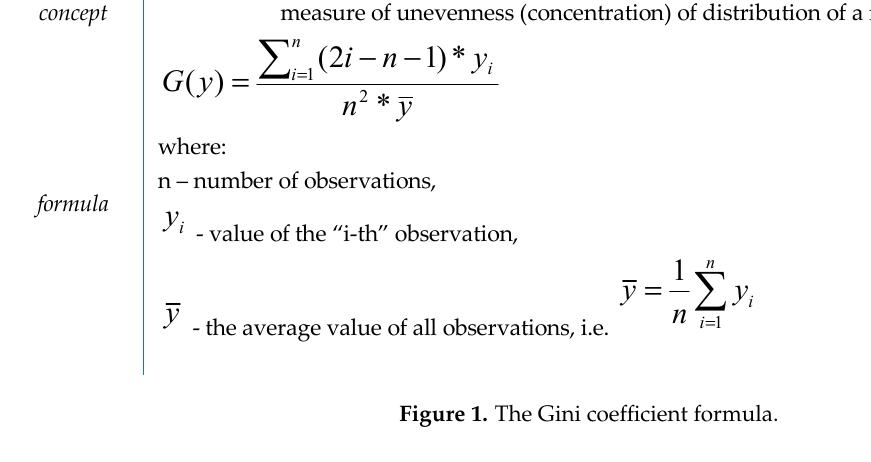
Figure 1. The Gini coefficient Figure 1 . The Gini coefficient formula .